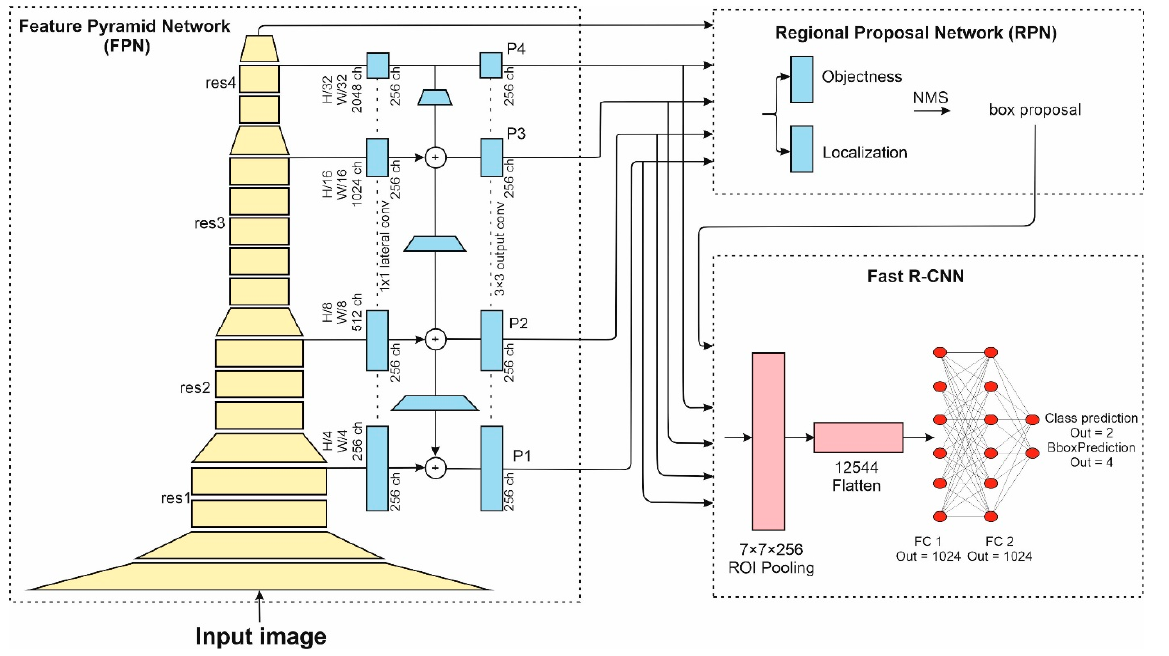
Figure 1. Architecture of the faster R-CNN deep learning network for defect detection.